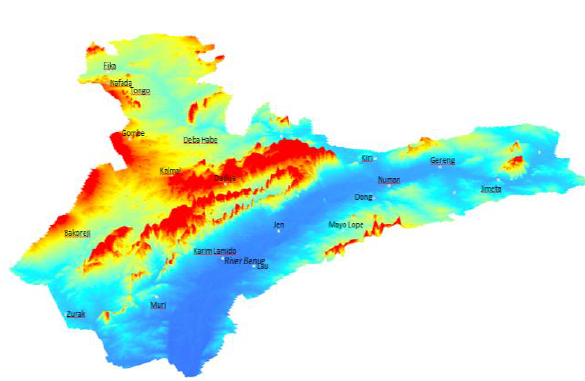
Figure 12. 3D view of the DEM of the Upper Benue Trough